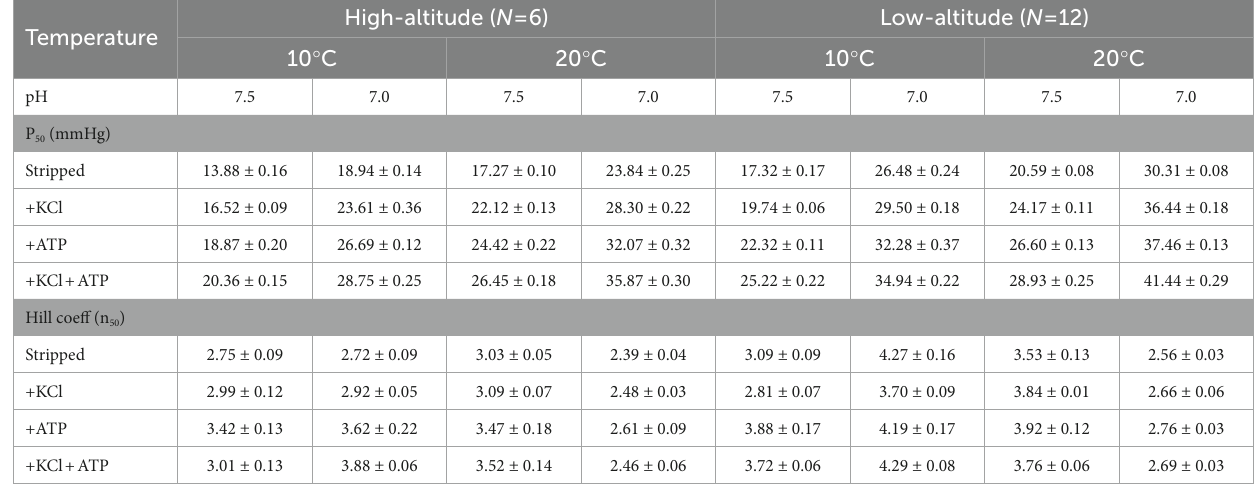
TABLE 3 Oxygen affinity (P 50 ) and Hill cooperativity coefficient (n 50 ) for high- and low-altitude black spotted frogs Hbs measured in different experimental conditions.